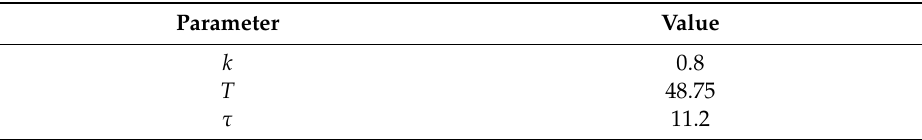
Table 7. Parameters of the transfer